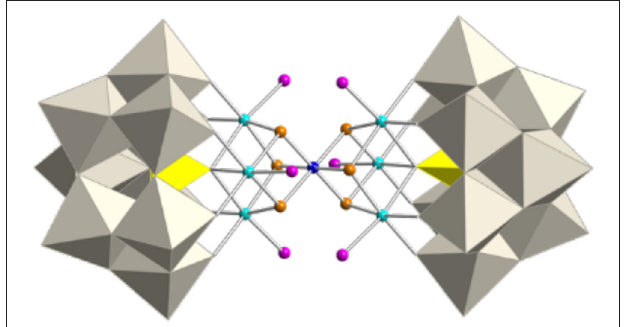
FIGURE 2 | Polyhedral and ball-and-stick representation of the POM [Co 7 (OH) 6 (H 2 O) 6 (PW 9 O 34 ) 2 ] 9 − ( 2 ). Gray octahedra, {WO 6 }, yellow tetrahedra; {PO 4 }, cyan spheres; Co II , blue sphere; Co III , orange spheres; OH, pink spheres, H 2 O.